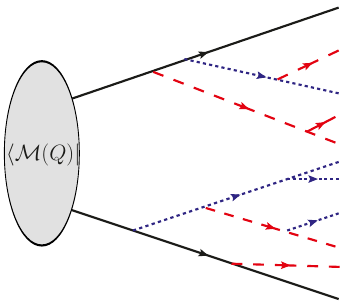
Figure 1. A term contributing to evolution of the conjugate amplitude (it contributes to A 9 ). Red dashed lines represent the emission of soft gluons and collinear partons are represented by blue dot- ted lines. Loops (Sudakov factors) have been neglected to avoid clutter. We draw all particles head- ing to the right, away from the hard process, including incoming particles. In contrast, evolution of the amplitude will have all particles drawn heading to the left and away from the hard